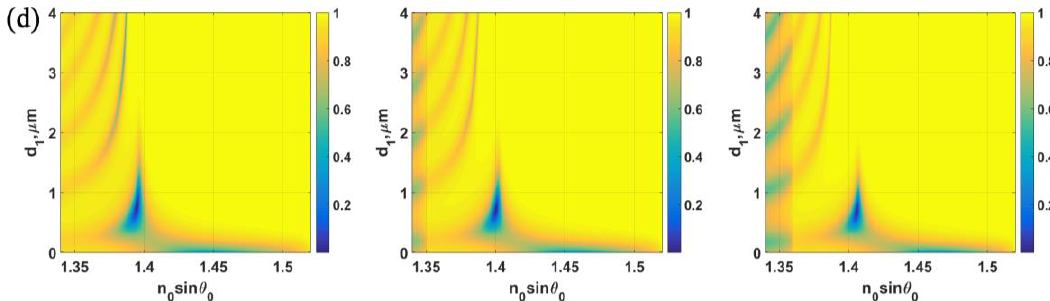
Figure 9. |r p | 2 responses for the following structure parameters. ( a ) n 0 = 1.52, n 1 = 1.3616, n 2 = 0.18344 + 3.4332 i with d 2 = 20 nm; ( b ) n 0 = 1.52, n 1 = 1.3616, n 2 = 0.18344 + 3.4332 i with d 2 = 30 nm; ( c ) n 0 = 1.52, n 1 = 1.39, n 2 = 0.18344 + 3.4332 i with d 2 = 20 nm; ( d ) n 0 = 1.52, n 1 = 1.39, n 2 = 0.18344 + 3.4332 i with d 2 = 30 nm. Each column represents responses due to different sample refractive indices, n 3 = 1.34, 1.35 and 1.36 shown in left, middle and right columns, respectively. Table 1. The performance evaluation parameters for SPR excited by Kretschmann configuration, LRSPP excited through evanescent wave coupling and LRSPP excited by interferometric mode. Structure Parameters n 1 , d 1 ,